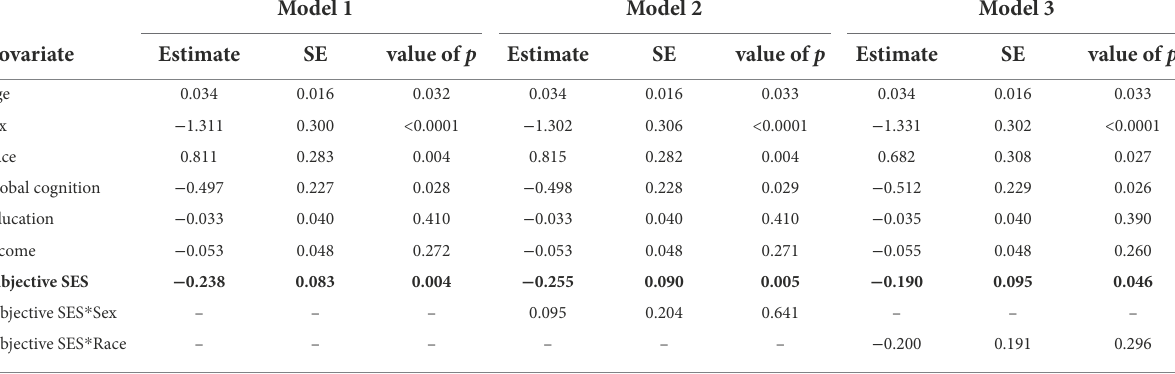
TABLE 4 Results of the nonlinear mixed effects model examining the association of subjective socioeconomic status (SES; bolded in table) with risk aversion (Model 1). Additional models examined whether sex (Model 2) or race (Model 3) modified the relationship between subjective SES and risk